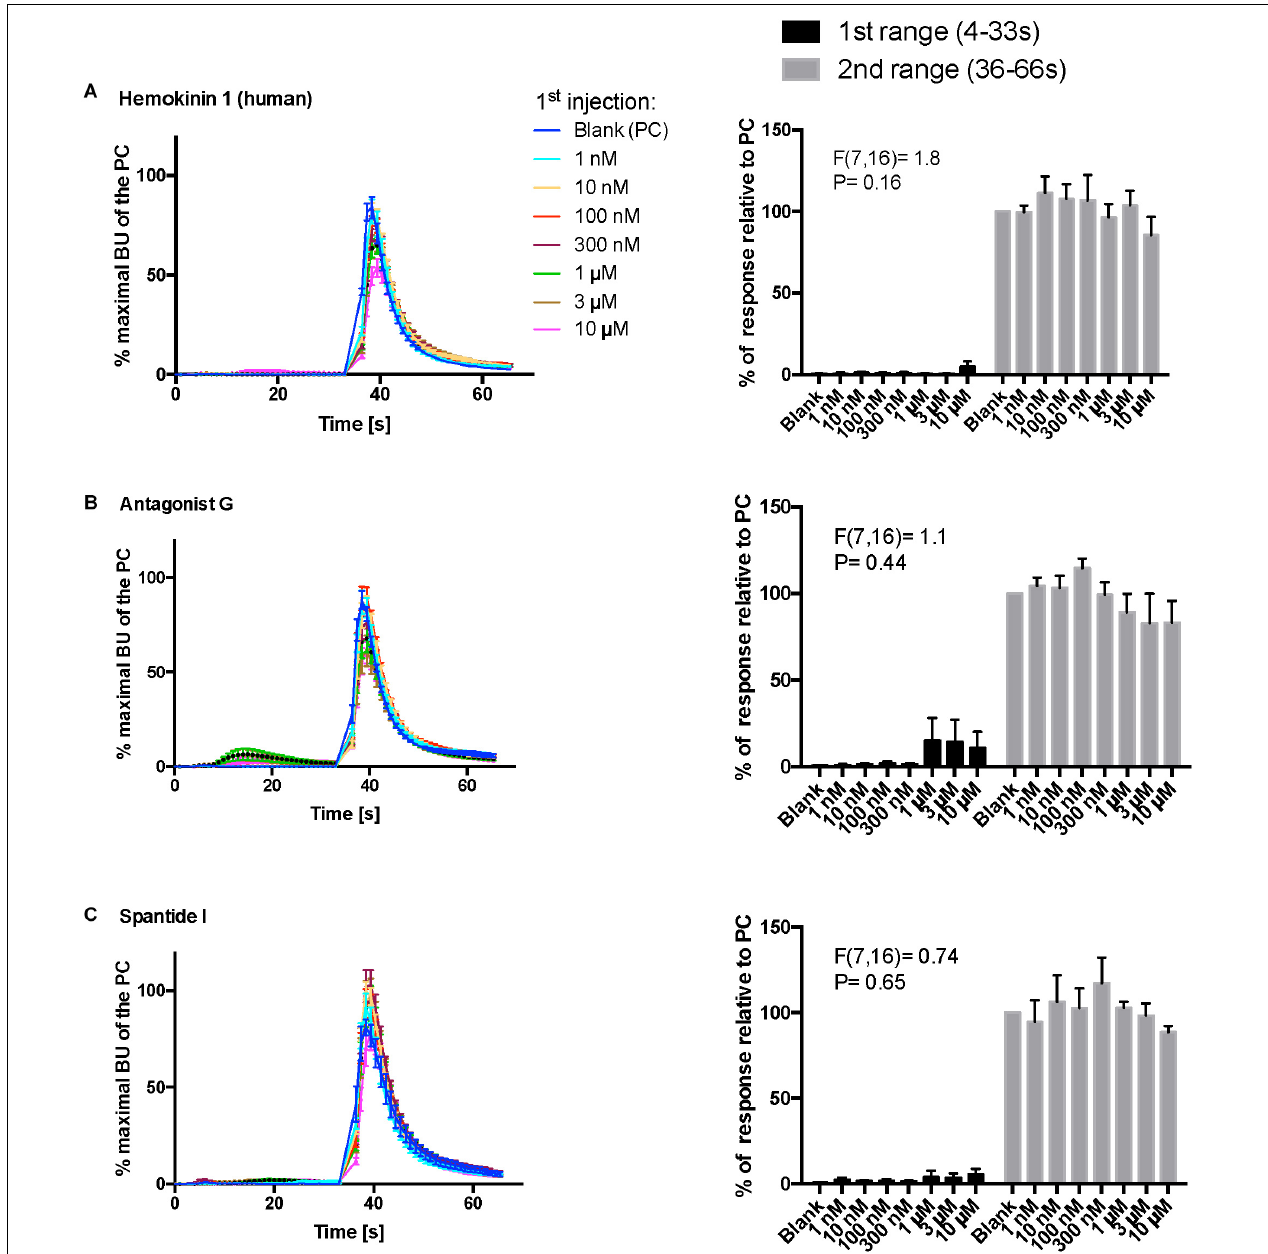
FIGURE 8 | Kinetic dose-responses of the BMLK3 cell to three peptidomimetic ligands of mammalian neurokinin receptors in the “dual-addition” calcium bioluminescence assay. Kinetic bioluminescence responses of tick kinin receptor recombinant cells to (A–C) three peptidomimetics (1 nM–10 µ M, n = 3). Two additions were performed by the two injectors built-in the Clariostar TM plate reader (BMG LABTECH) as follows: the first addition of various concentrations of peptidomimetics (10 × ), or corresponding blank buffer, was performed at 2 s after initiation of the recording. The response to the first addition was recorded for 30 s with 1 s intervals (first range). At 32 s, the second addition of the agonist of tick kinin receptor (1 µ M FFFSWGa) was performed in the same well, and the cellular response was recorded for another 30 s with 1 s intervals (second range). Curves on the left of each panel depict in different colors the kinetic response in bioluminescence units (BU) per second to each concentration (8–9 wells from three independent assays). The Y -axis represents the percentage BU of each concentration normalized to the maximal BU of the positive control (blank buffer + agonist, blue curve) (mean ± SEM). The histogram on the right of each panel shows sequentially the total BU responses of cells to the two additions, the first and second range recordings, respectively. The total responses in each range was expressed as the percentages of the average BU (per second) obtained in each of the two 30 s-ranges, relative to the average units to the PC in the second range (average BU of the blue curve at 35–65 s). In each independent assay, the total response to each concentration of each peptidomimetic in the first addition or to the agonist in the second addition was calculated as the average of 2–3 pseudo-replicate wells ( Y axis: mean ± SEM, n = 3 independent assays). None of the tested compounds showed agonist activity (for B panel, first range, see explanation in text). Statistical differences in inhibitory activities between different concentrations of each compound were analyzed by one-way ANOVA ( n = 3) but no statistical differences were detected.